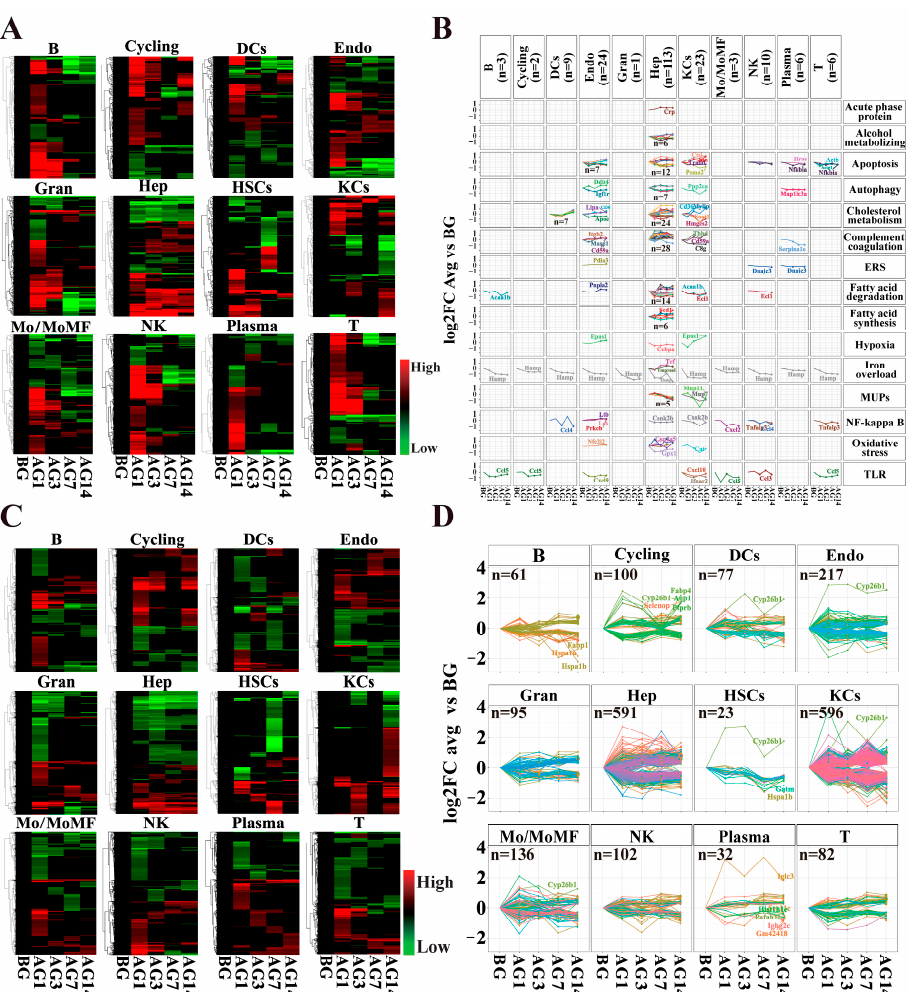
Figure 3. The alcohol-induced liver injury mainly occurred in hepatocytes, endothelial cells and Kupffer cells. ( A ) Heatmap of gene expression of ALD-related genes in different liver cell types. ( B )